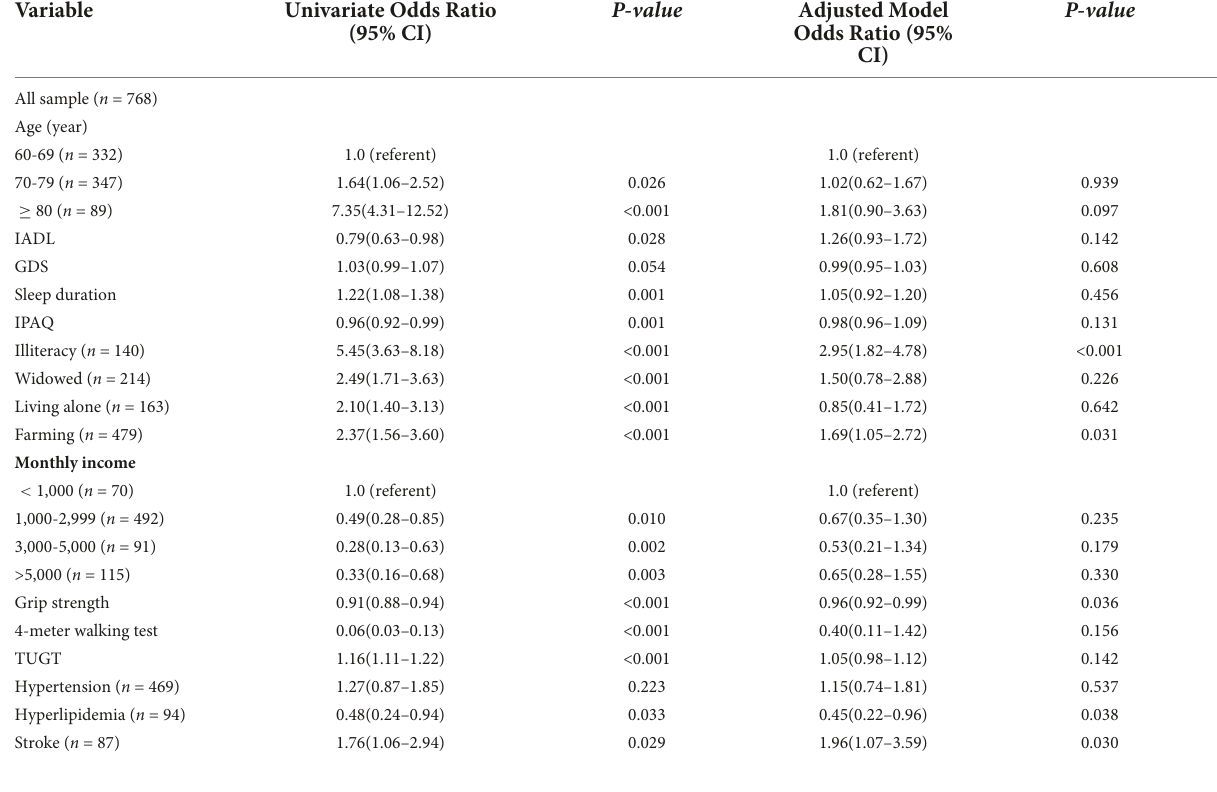
TABLE 3 Unadjusted and adjusted model for factors related to MCI in the female.